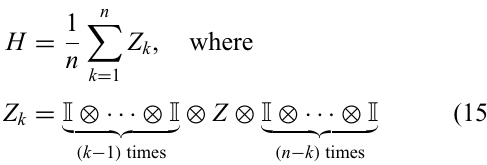
= (cid:3) U | ψ (cid:9)(cid:10) ψ | U † − 1